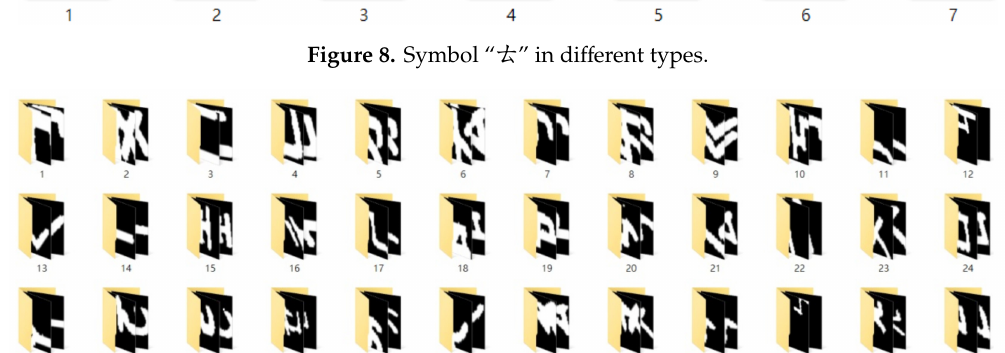
Figure 8. Symbol “ ㄊ ” in di ff erent types.